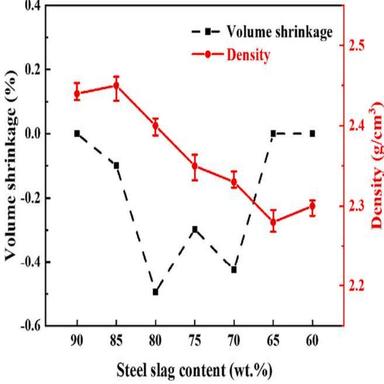
Volume shrinkage and Density of samples after sintering at 1200 ◦C with different pretreated steel slag contents.